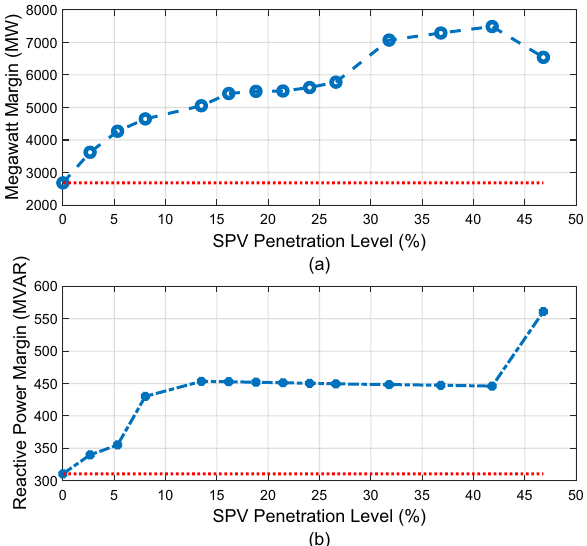
Figure 14. Variation of megawatt margin and reactive power margin with SPV PL.